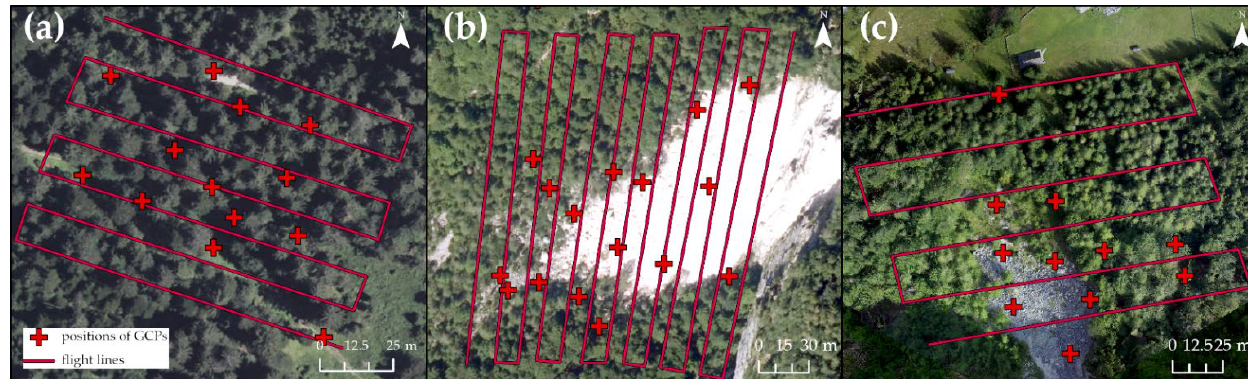
Figure 5. Flight paths of the UAV surveys and locations of ground control points (GCPs) for ( a ) Jelovica, ( b ) Cerkev (the same for all surveys), and ( c ) Kekec.